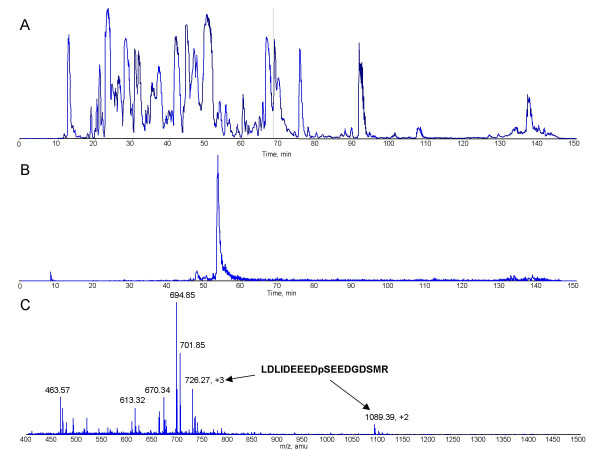
Tandem mass spectrometric analysis of the E1 tryptic digest. A. Base peak ion chromatogram obtained by HPLC/ESI-qTOF MS and MS/MS analysis of the E1 tryptic digest. B. Selected ion retrieval for m/z 1088.8, which corresponds to the doubly-charged tryptic phosphopeptide LDLIDEEEDpSEEDGDSMR. C. Full scan mass spectrum at RT 53.1 min showing the presence of several tryptic peptides including the doubly and triply-charged phosphopeptide LDLIDEEEDpSEEDGDSMR.